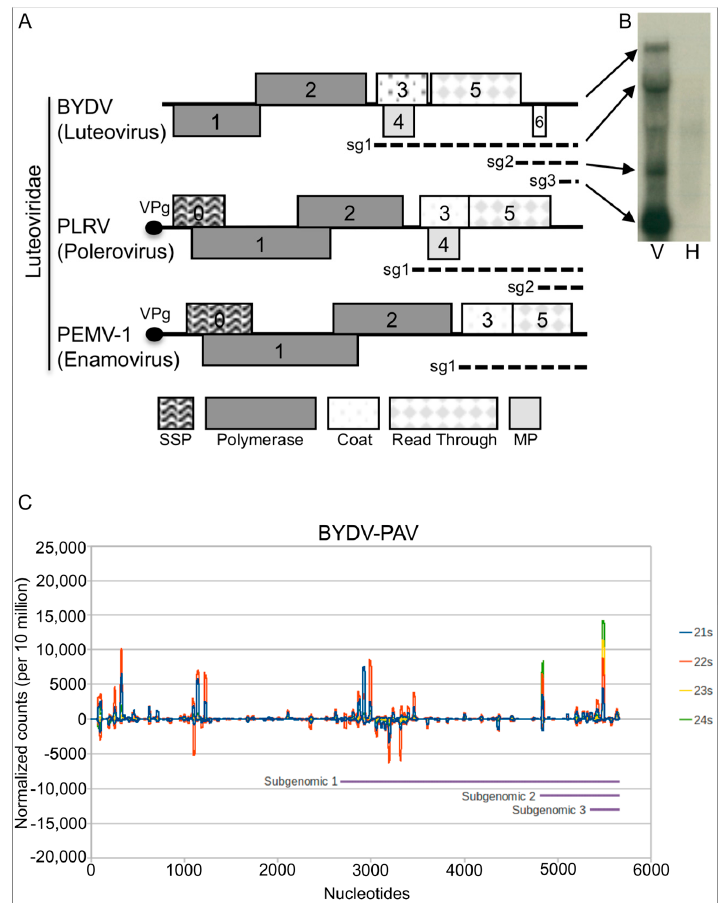
Figure 1. Genome organization of the family Luteoviridae and mapping of perfect match 21 to 24 nt virus-derived small RNAs from barley yellow dwarf virus-PAV (BYDV-PAV)-infected plants. ( A ) Genome organization of viruses belonging to the three genera of the family Luteoviridae . Numbers within rectangles indicate known luteovirid ORFs: silencing suppressor protein (VSR), polymerase, coat-protein, read-through transmission protein and movement protein (MP). Subgenomic RNAs (sg1, sg2 and sg3) are represented as dotted lines. ( B ) Northern blot from virus-infected (V) and healthy (H) plants showing the accumulation of genomic and subgenomic BYDV-PAV RNAs (reproduction from Kelly et al. 1994 [33]). ( C ) Profiles of 21 to 24 nt size reads mapping to the BYDV-PAV genome deep-sequenced from barley-infected plants. Profile is shown as a cumulative number of reads per nucleotide, normalized to the total library size per 10 million reads. Reads that aligned to the negative strand are plotted as negative Y-axis values. Purple bars show the sub-genomic RNA regions (positions starting at 2678, 4817 and 5356). 'Hot-spots' or peaks of read counts can be seen across the genome.